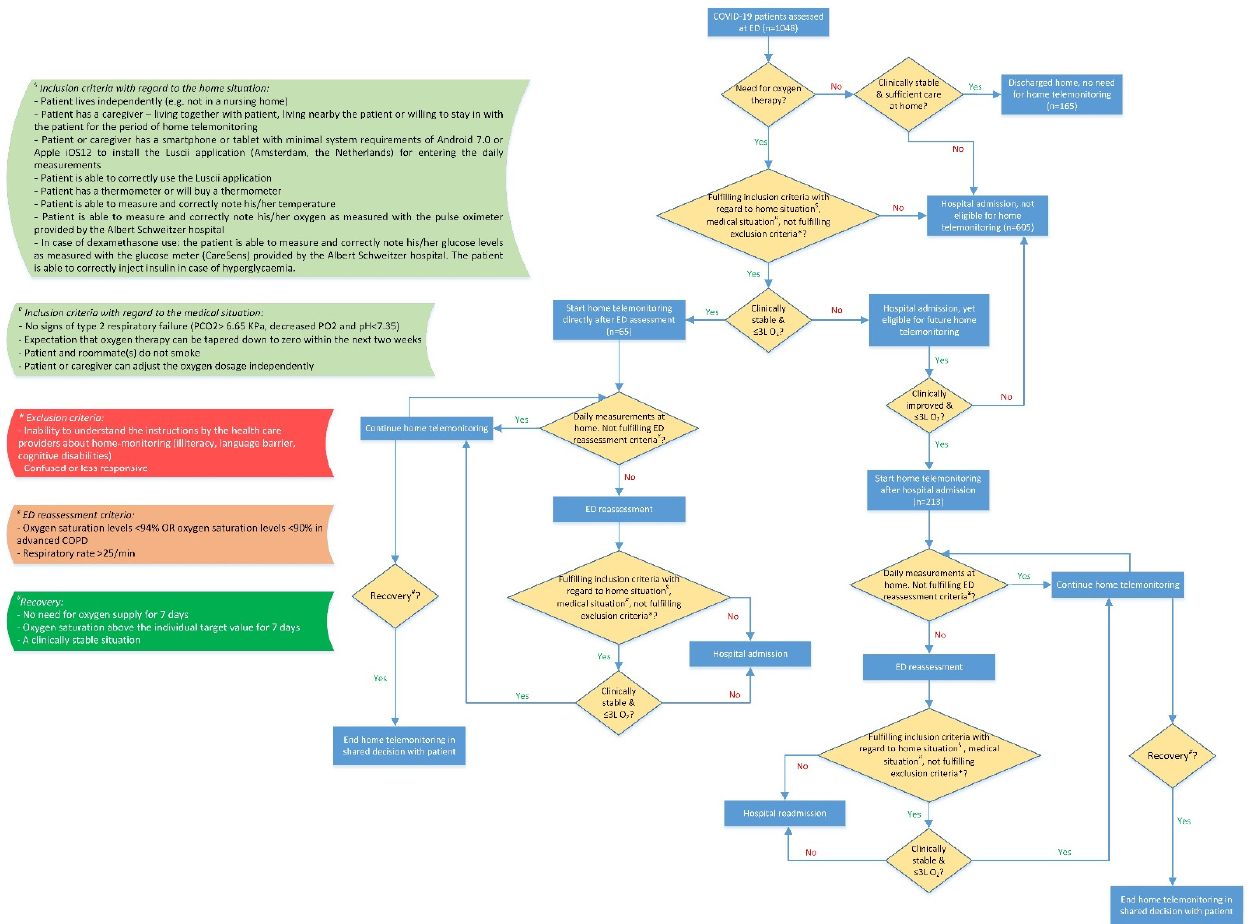
Figure 1. Flowchart of in- and exclusion criteria and decisions for home telemonitoring.